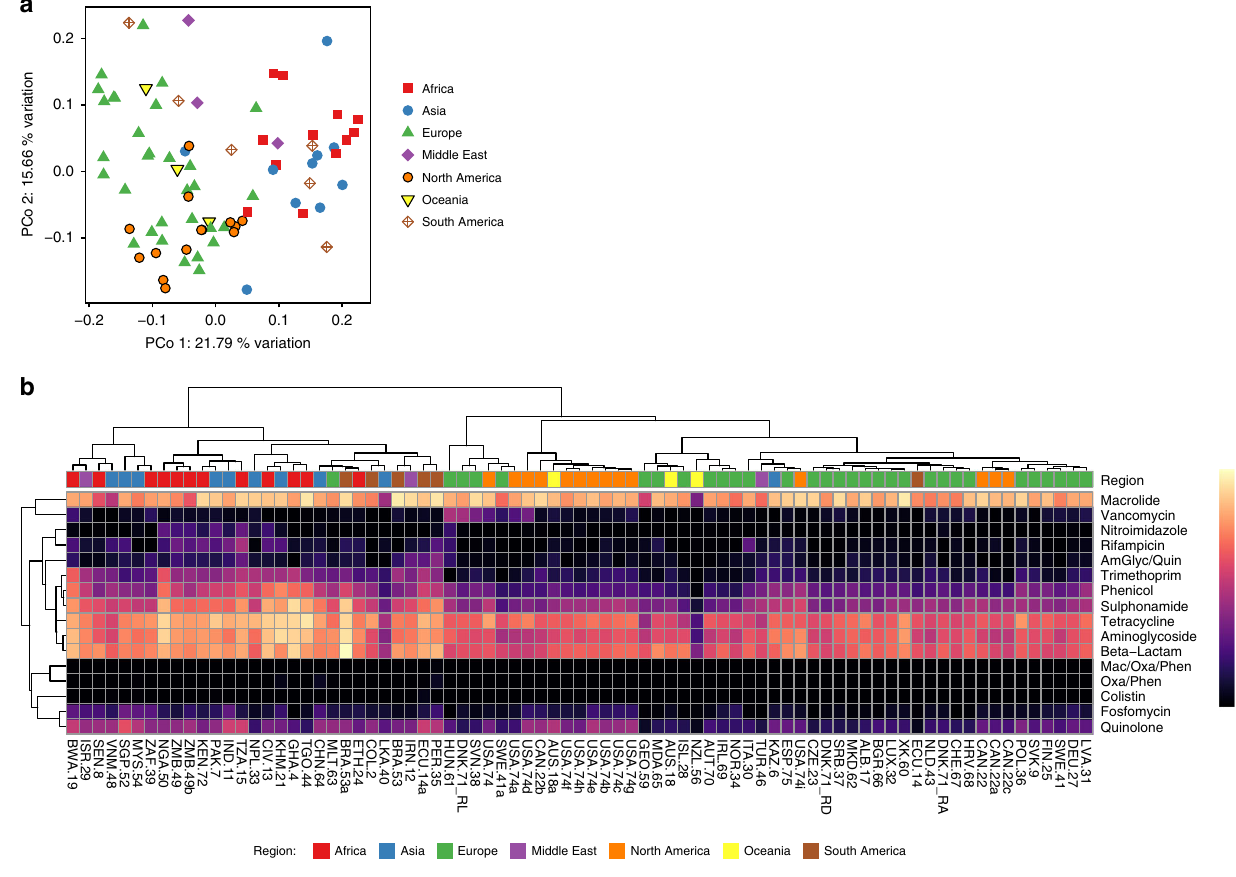
Fig. 2 Resistome clustering in sewage samples across regions. a Principal coordinate analysis (PCoA) performed on the resistome Bray – Curtis dissimilarity matrix. The amount of variation explained by coordinates 1 and 2 is included in the axis labels. b Antimicrobial resistance class-level heat map. Relative abundances of genes (fragments per kilo base per million fragments (FPKM)) were summed to drug classes (AmGlyc aminoglycoside, Mac macrolide, Oxa oxazolidinone, Phen phenicol, Quin quinolone). Colors represent log (ln) transformed relative abundances (FPKM). Complete-linkage clustering of Pearson correlation coef fi cients was used to hierarchically cluster both samples and drug